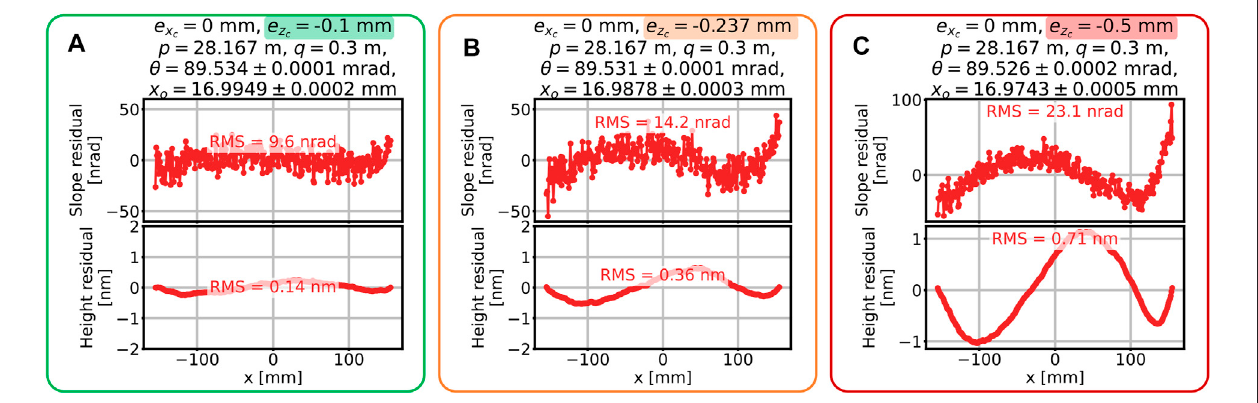
(cid:2) 70 nrad angular noise: (A) when e a